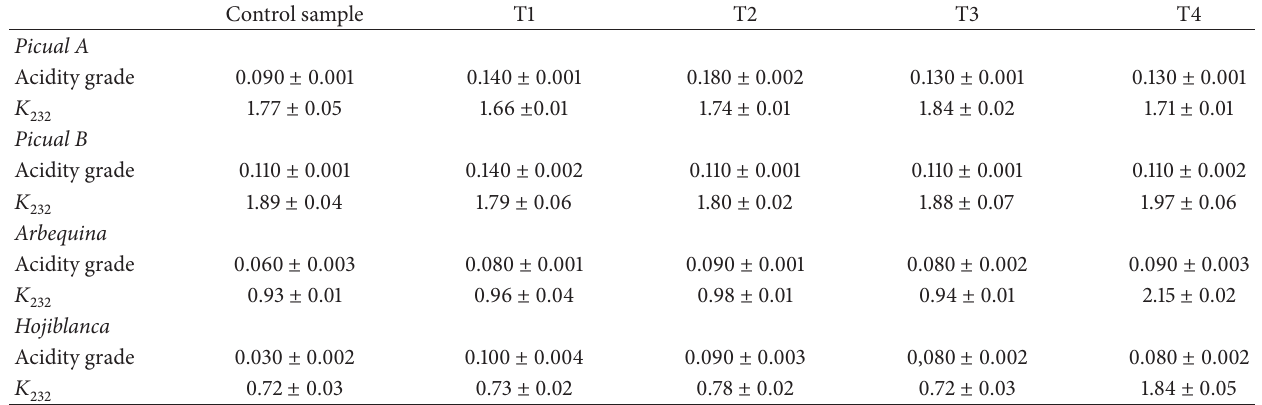
Table 1: Quality